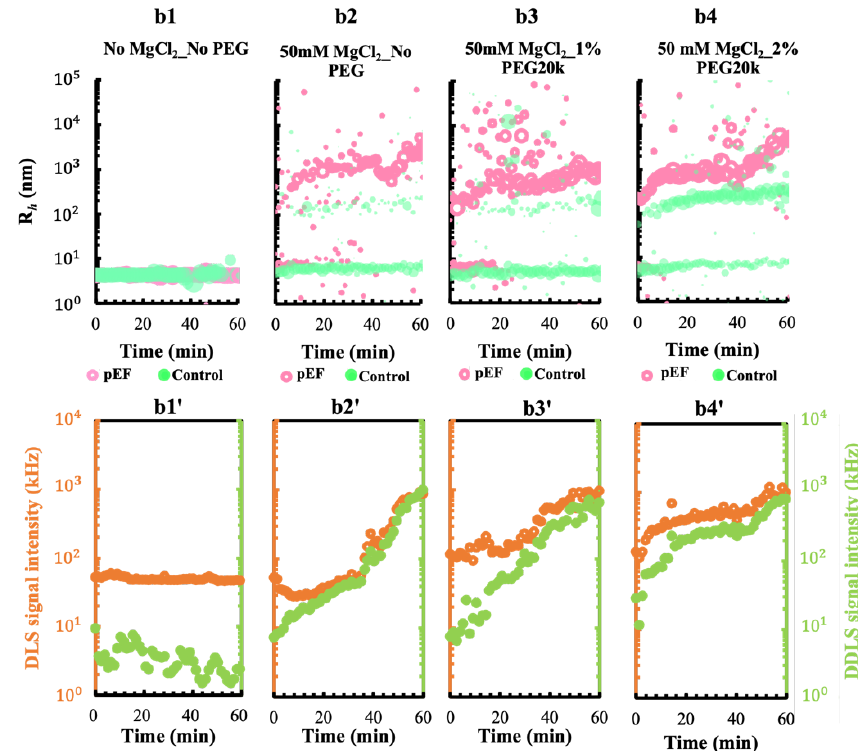
Figure 7. The effect of a pulsed electric field on the phase behavior of GI in a solution with different ions and PEG conditions. ( a1 – a4 ) Development of the hydrodynamic radii of 2 mg/mL GI with PEG20k in a buffer containing10 mM MES pH 6.5, 100 mM NaCl exposed to a pEF (green open circles) and without pEF (purple bubbles). ( a1 (cid:48) – a4 (cid:48) ) The corresponding DLS (left Y-axis, orange open circles) and DDLS (right Y-axis, green closed circles) signal intensities of the pEF group monitored with a buffer containing 100 mM NaCl. ( b1 – b4 ) Evolution of the hydrodynamic radii of a 2 mg/mL GI solution mixed with PEG20k and buffer condition of 10 mM MES PH 6.5, 50 mM MgCl 2 with a pEF (pink open circles) and without pEF (green bubbles). ( b1 (cid:48) – b4 (cid:48) ) The corresponding DLS and DDLS signal intensities of the pEF group monitored in a buffer containing 50 mM MgCl 2 . DLS/DDLS signal intensities of each control condition without pEF are shown in Figure